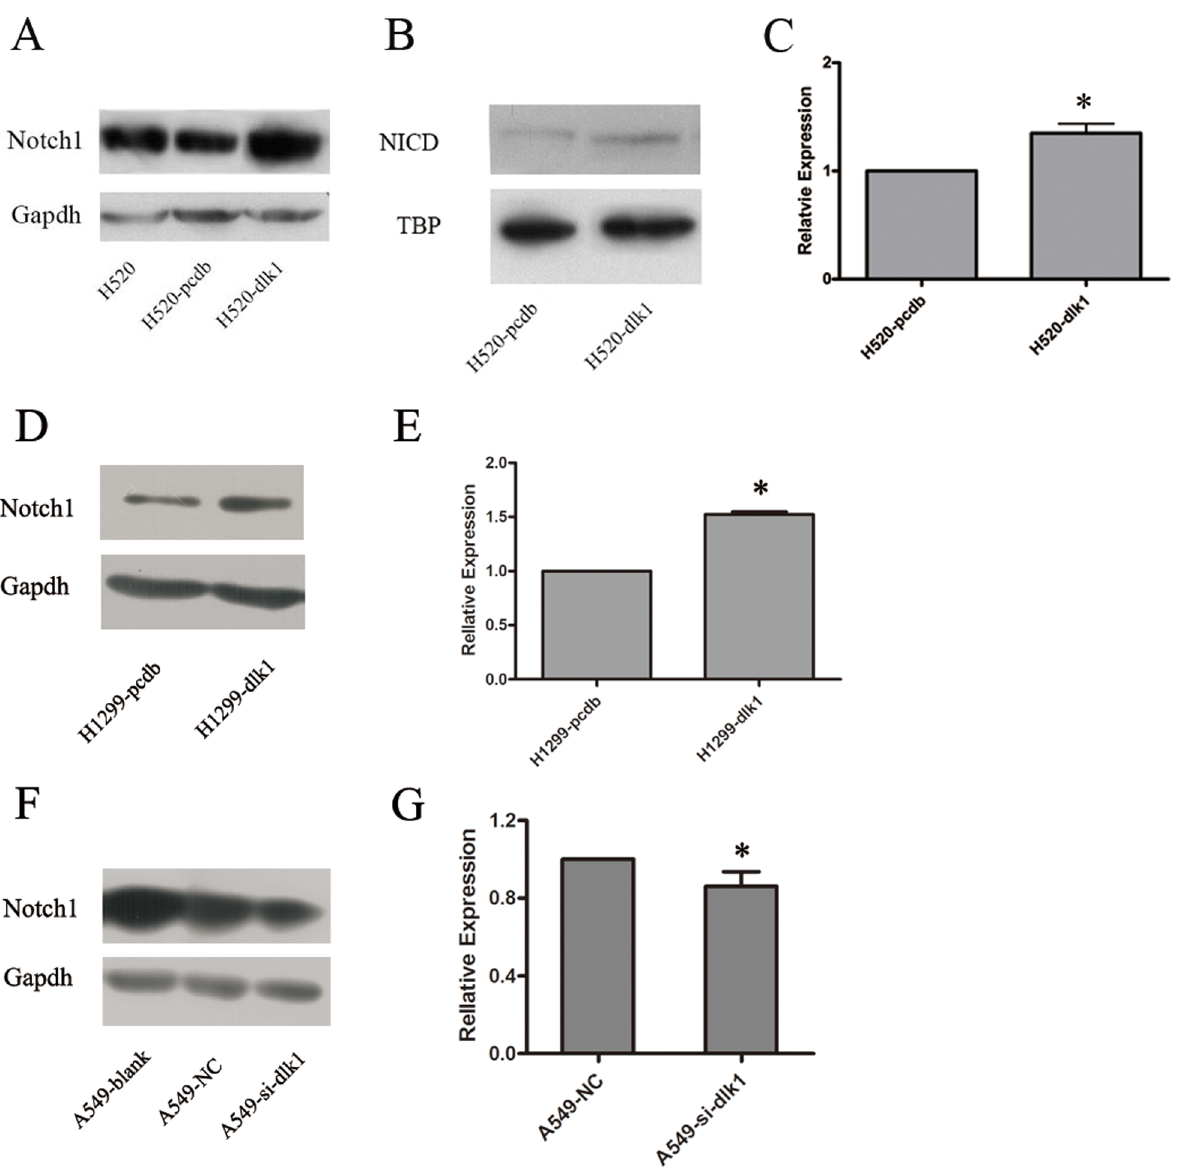
Figure 3. Effects of DLK1 on the Notch signaling pathway in the human lung cancer cells. A, Western blotting showing NOTCH1 expression in H520 cells after transfection with DLK1 (H520-dlk1) or null vector (H520-pcdb)examined in whole-cell lysates. GAPDH was used as an internal control. B, Western blotting evaluating nuclear NICD expression in H520-dlk1 andH520-pcdb cells. TBP was used as an internal control. C, a histogram for the relative mRNA expression of Notch target gene HES1 in the H520-dlk1 and H520-pcdb cells detected by real-time PCR analysis. H520-pcdb cells were used as a control, and its expression level of HES1 was set to 1. 18S ribosomal RNA was used as an internal control. D, Western blotting showing the expression of NOTCH1 in H1299 cells transfected with DLK1 (H1299-dlk1) or null vector (H1299-pcdb). GAPDH was used as an internal control. E, a histogram presenting the relative mRNA expression of HES1 in H1299-dlk1 and H1299-pcdb cells detected by real-time PCR analysis. F, the expression of NOTCH1 in cytoplasm were evaluated by Western blotting in A549 cells transiently transfected with DLK1 siRNA (A549-si-dlk1) or null control siRNA (A549-NC). GAPDH was used as an internal control. G, real-time PCR analysis of the relative mRNA expression of HES1 in A549-si- dlk1 and A549-NC cells, and presented in a histogram. The experiments were performed in triplicate (* t-test, p-value ,